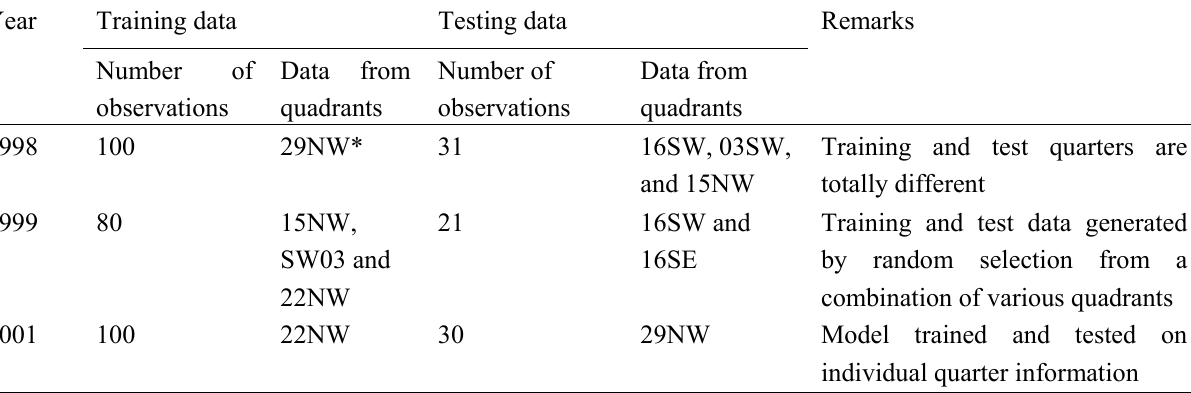
Table 1. List of dataset used for hybrid BPNN yield prediction models of various